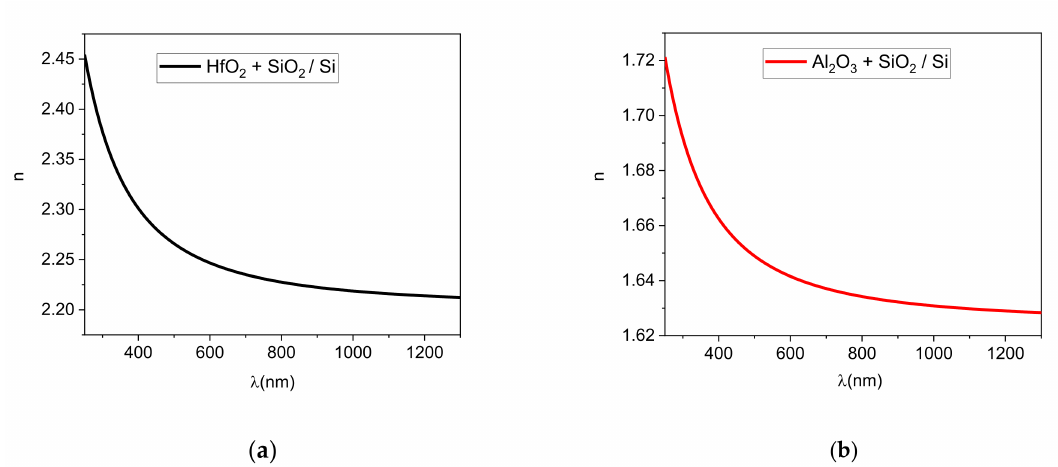
Figure 4. The dispersion of the refractive index calculated from SE by using Cauchy dispersion formula ( a ) for hafnium silicate and ( b ) aluminium silicate